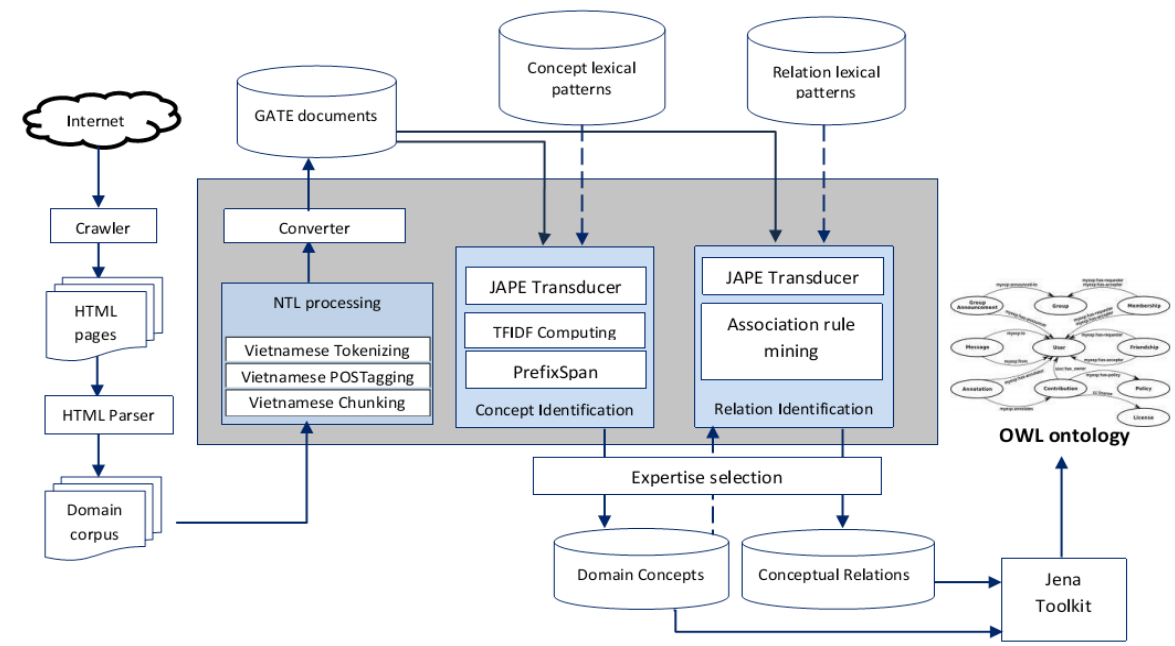
Figure 3. Overall construction